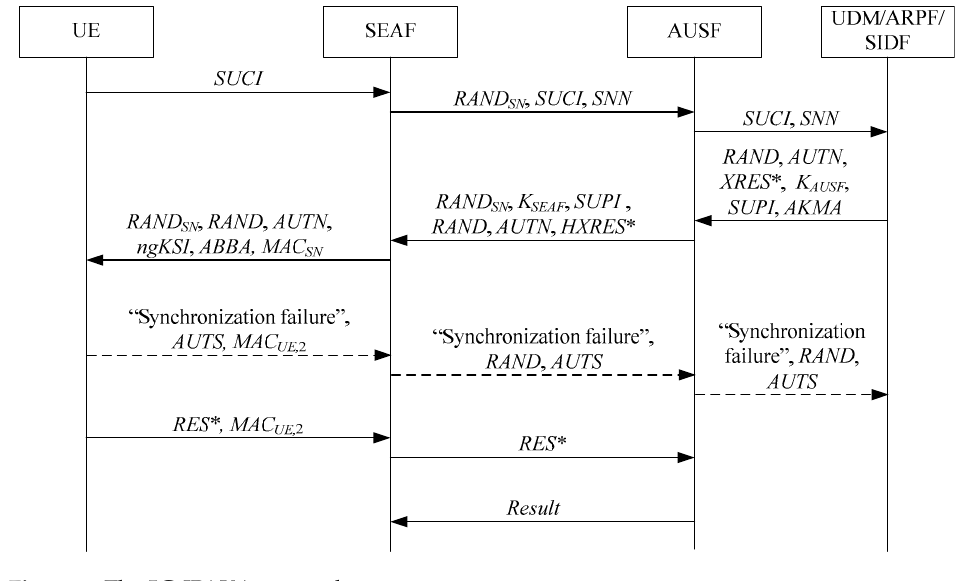
Figure 2. The 5G-IPAKA protocol.